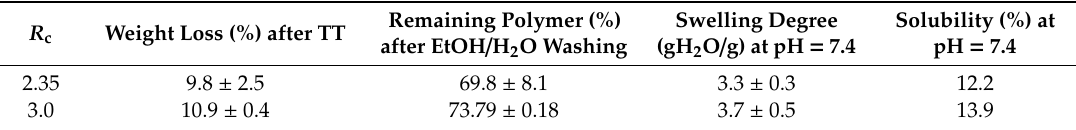
Table 3. Weight Loss for Thermal Treatment at 120 ◦ C for 4 h and Stability of PEC / PEO Nanofibers for R c = 2.35 and